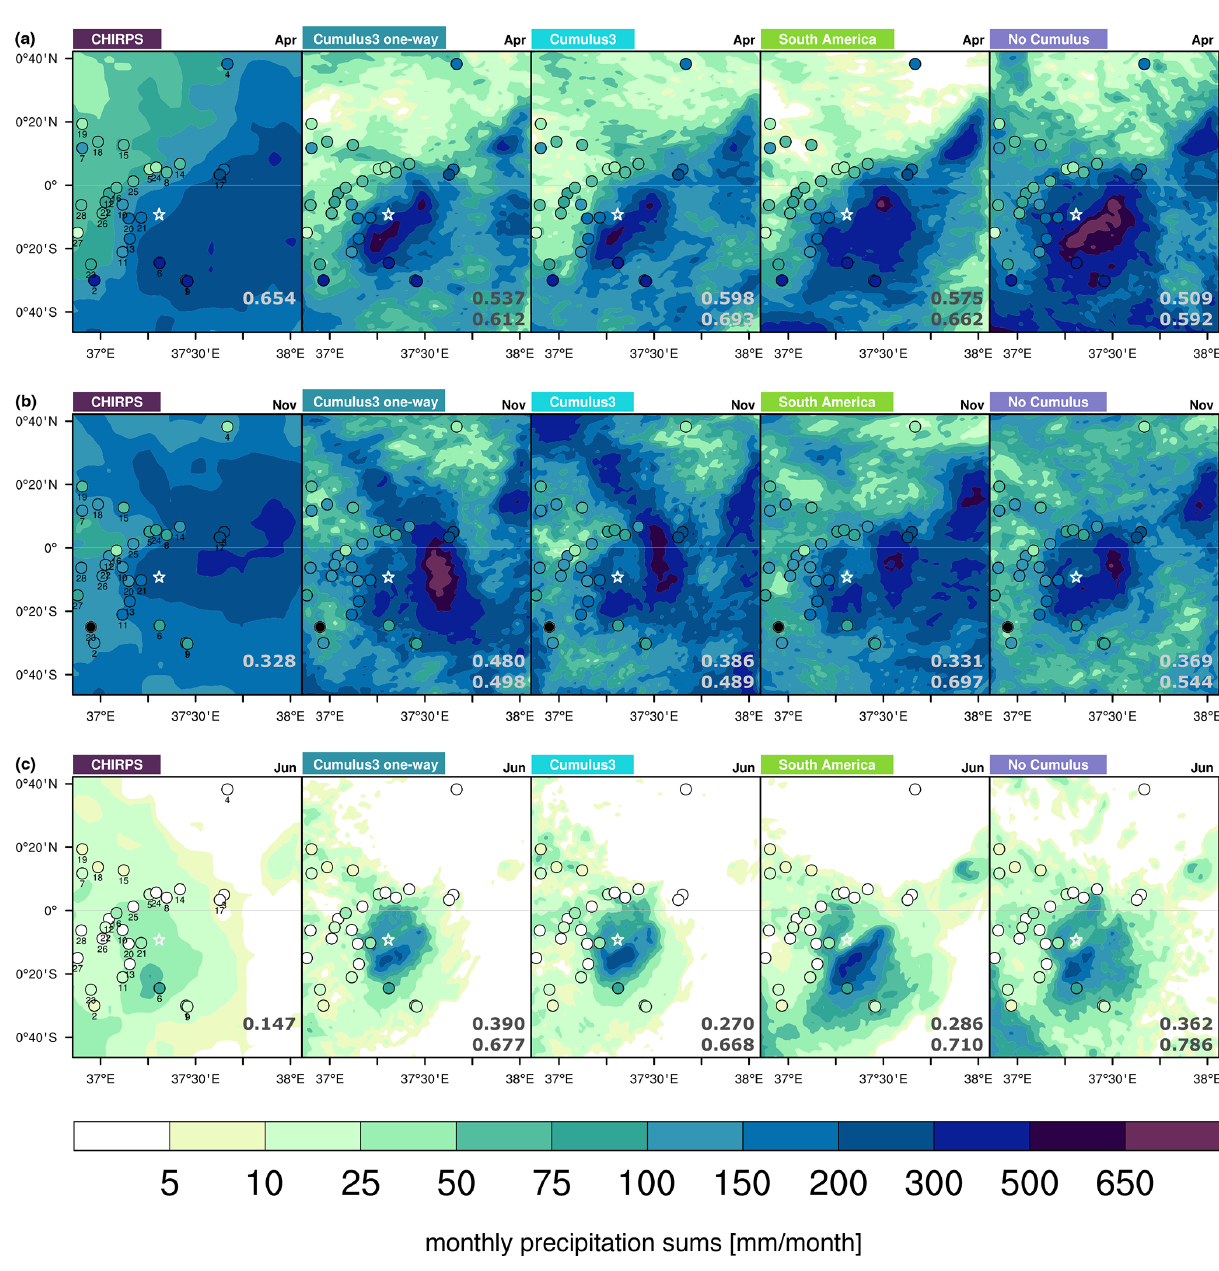
Figure 6. Monthly precipitation sums for (a) April 2008 (long rains), (b) November 2008 (short rains), and (c) June 2008 (dry season) in millimetres per month for the innermost domain (1km) of the four-domain nested setup, with an outermost domain of 27km resolution and a nesting ratio 1:3 for the different parameterization setups (see Table 1). Weather station data are described in Table 2. The white star indicates the summit of Mount Kenya, and missing values are marked in black. The numbers in the lower-right corner of each panel indicate the spatial correlation with respect to the stations (upper line) and CHIRPS (lower